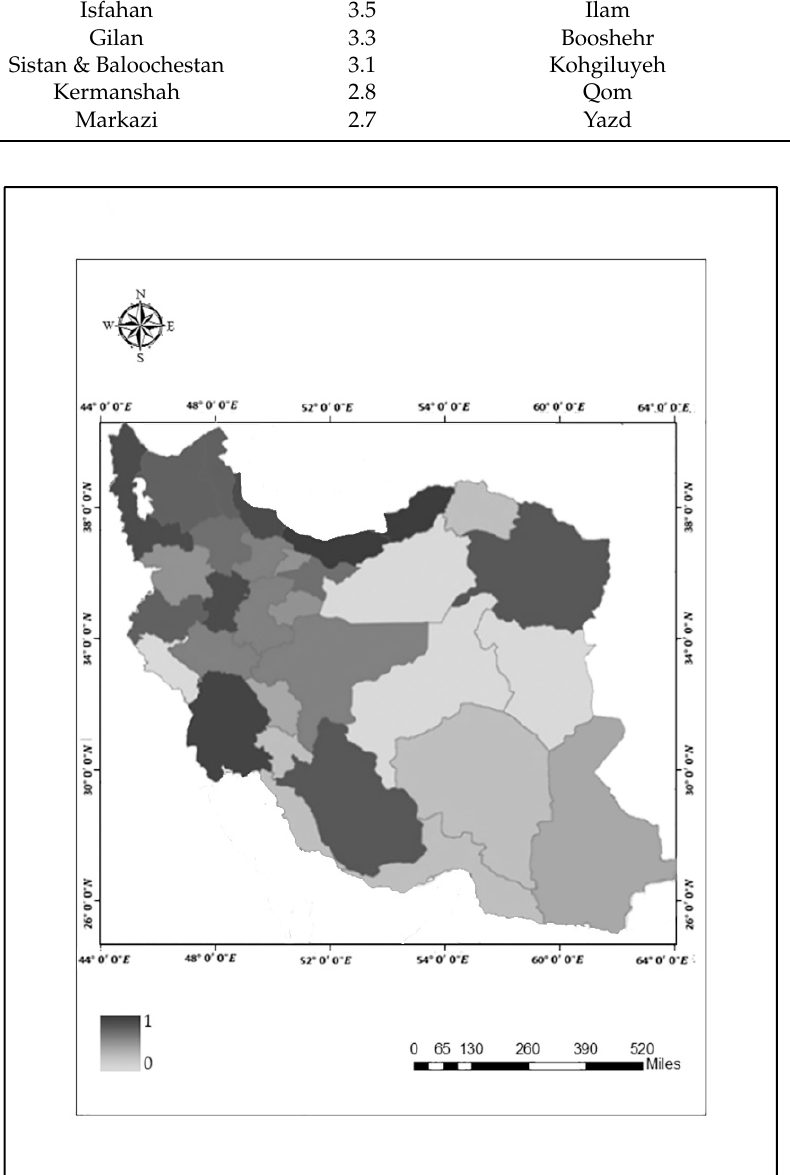
Figure 12. Final exposure map of Iran